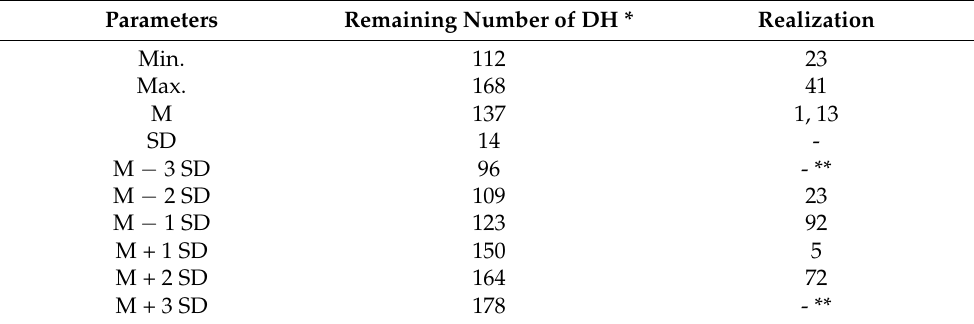
Table 8. Statistics of the remaining number of DHs after involving the rejection criteria for the Q1 paths obtained from the 49 realizations.